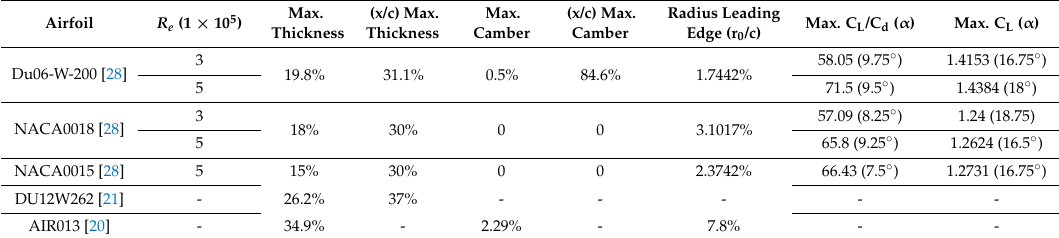
Figure 12. Contours of the velocity and stream lines at different angles of attack: ( a – g ) the contours of the velocity at different angles of attack. This figure shows the transient contours from the angle of attack α = − 20° to the angle of attack α = 22° at R e = 3 × 10 5 . However, only the varying velocity on the upper surface of the LUT and the larger vortex are captured in this figure due to the picture being limited by the ability of the Particle Image Velocimetry (PIV) equipment. Table 1. Main geometrical parameters and aerodynamic parameters of a part of commonly used airfoils for straight-bladed